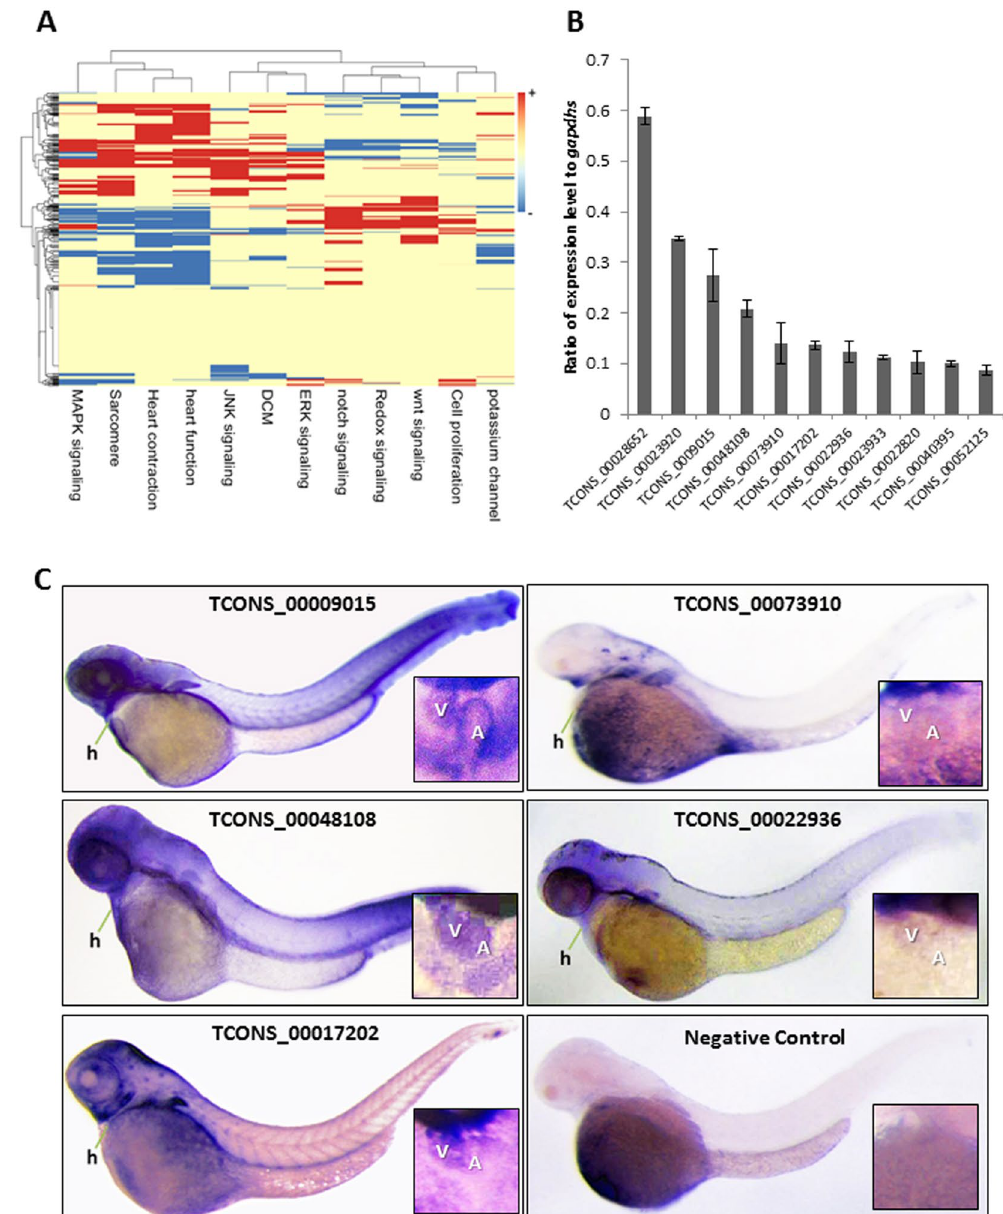
Figure 5. Analysis of embryonic heart–enriched lincRNAs. ( A ) Expression-based association matrix of 564 embryonic heart–enriched lincRNA transcripts (rows) and functional gene sets (columns). Red, positive correlation; blue, negative correlation; yellow, no correlation. ( B ) Expression of embryonic heart-enriched lincRNAs, as revealed by Quantitative real-time PCR. gapdhs (FPKM = 127) was used as reference gene. Means ± S.D. N = 3. ( C ) Validation of 5 selected lincRNAs with high embryonic cardiac expression by in situ hybridization at 2-days post fertilization (2 dpf), and negative control is a lincRNA candidate with low FPKM in embryonic heart. A, atrium; h, heart; V,